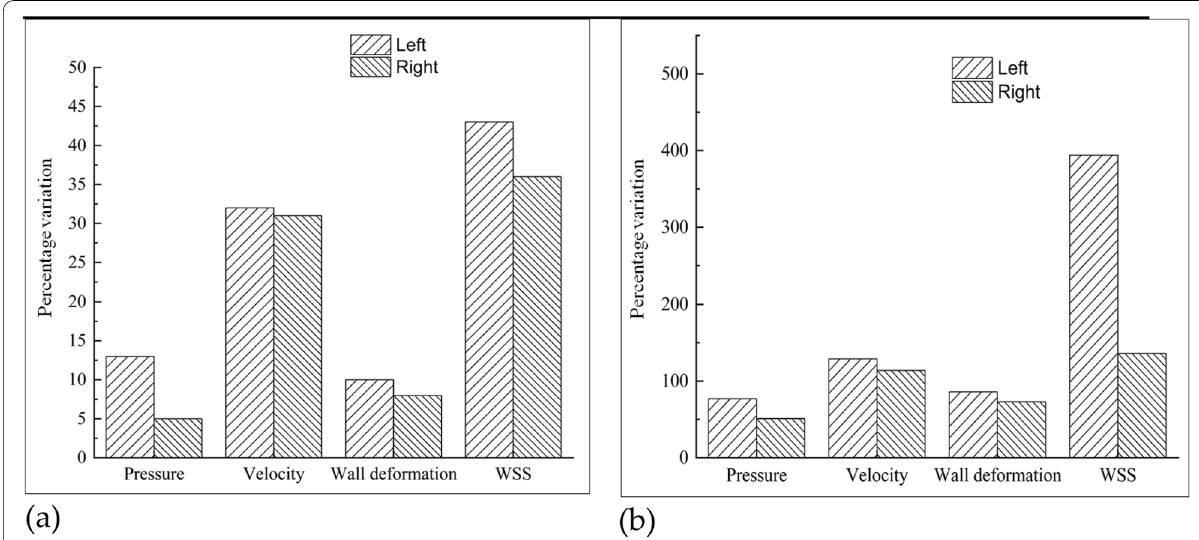
Fig. 5 Percentage variation during change of posture. a : From SL to ST; b : From SL to